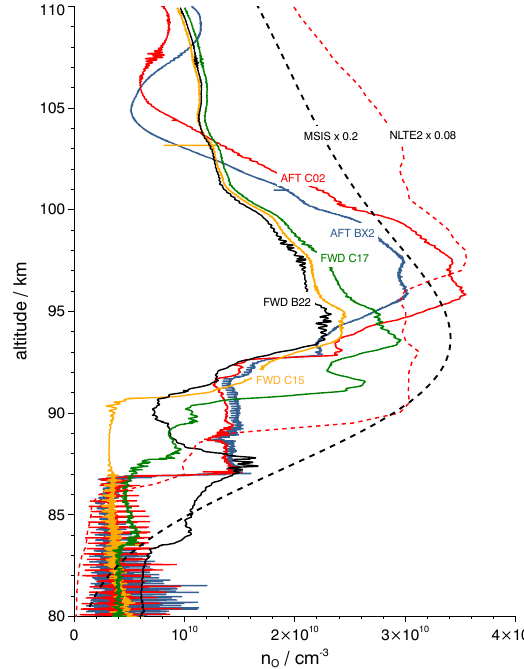
Figure 14. Profiles of O number density for FIPEX sensors on fore and aft deck after aerodynamic ram correction. Downleg profile for aft sensors, upleg part for the fore sensors. Comparison to MSIS model and NLTE-2 measurements.